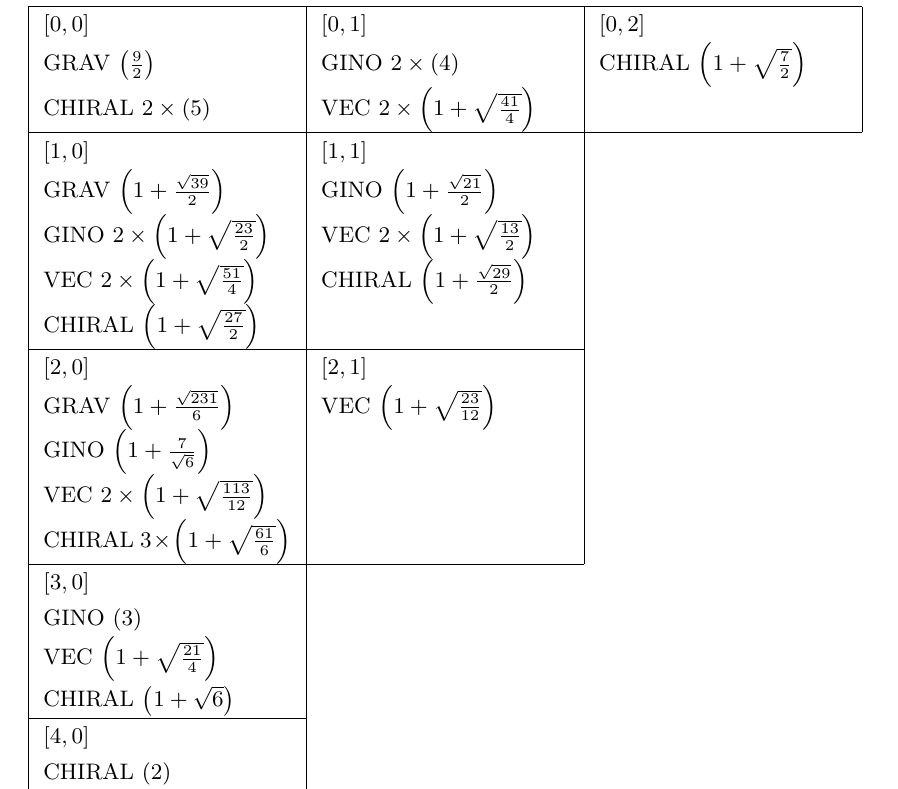
Table 4 . Supermultiplets at KK level n = 2 for the D = 11 N = 1 G 2 -invariant AdS 4